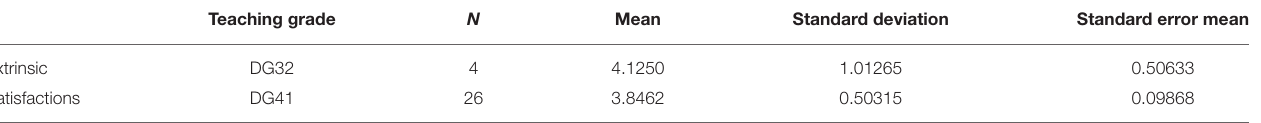
TABLE 7 | Mean difference for extrinsic